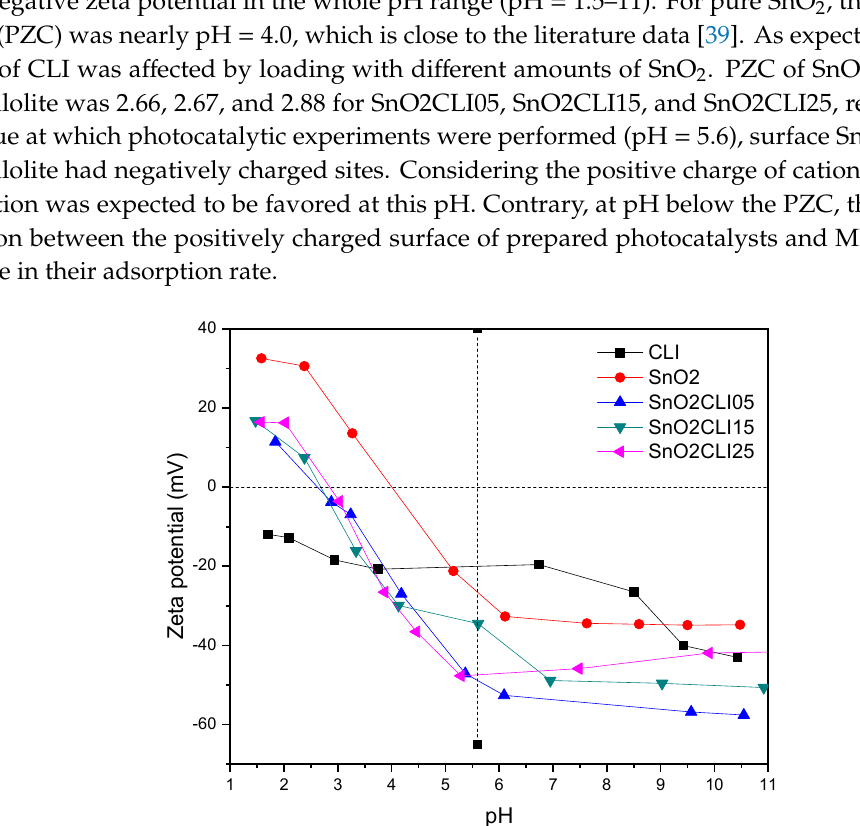
Figure 7. Attenuated total reflection (ATR)-FTIR spectra of ( a ) SnO 2 and ( b ) SnO 2 -containing clinoptilolite. In ( c ) a closer range (1400–800 cm − 1 ) is shown.